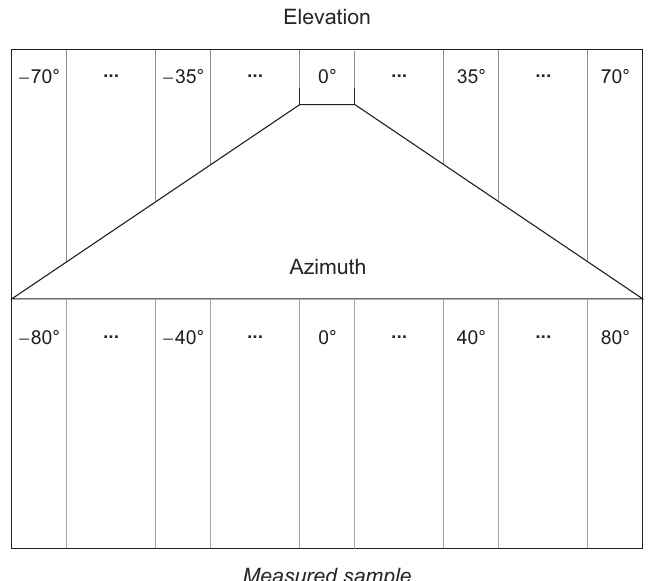
Figure 11. Presentation of the measured training data inside one distance between the UWB modules. The elevation was changing from − 70 degrees to 70 degrees with a step size of 5 degrees, with the central position at 0 degrees. The azimuth was changing from − 80 degrees to 80 degrees with a step size of 5 degrees, with the central position at 0 degrees inside each constant elevation.